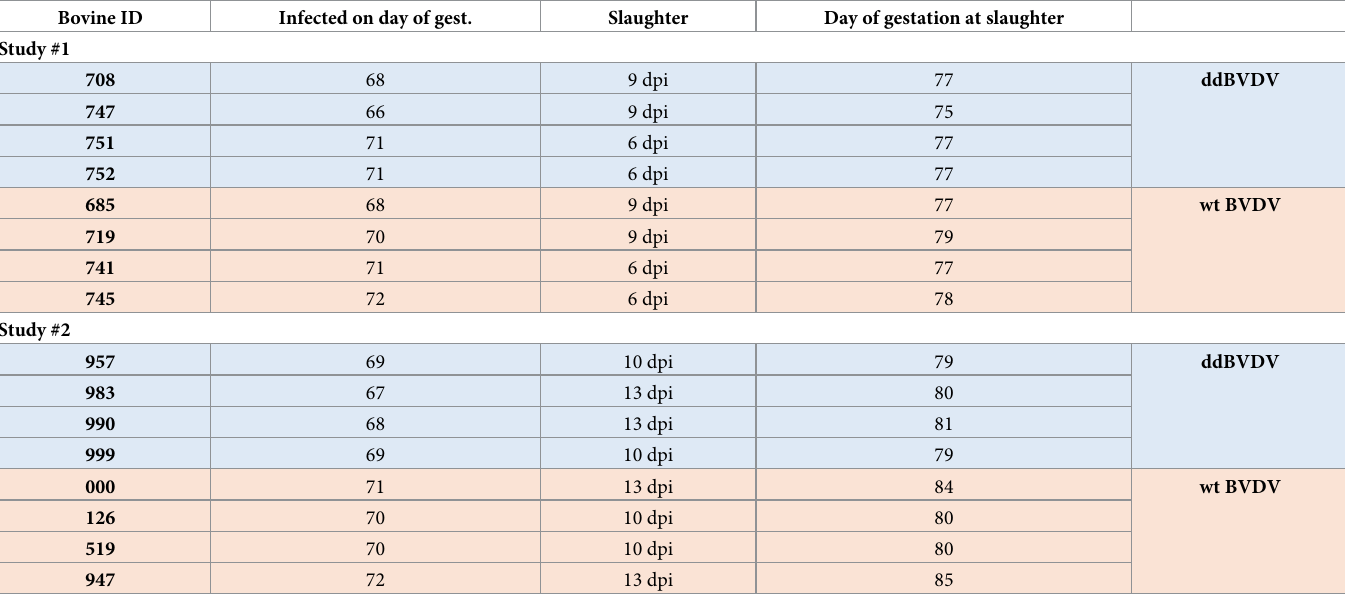
Table 1. Summary of heifer gestation and infection dates. Bovine ID Infected on day of